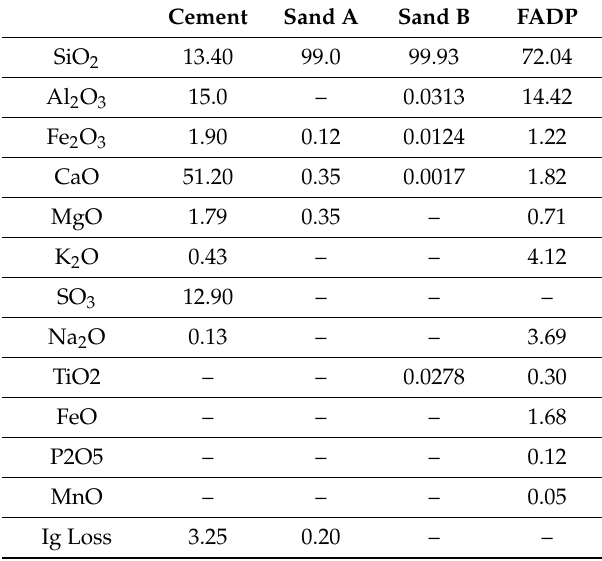
Table 2. Chemical component of materials.